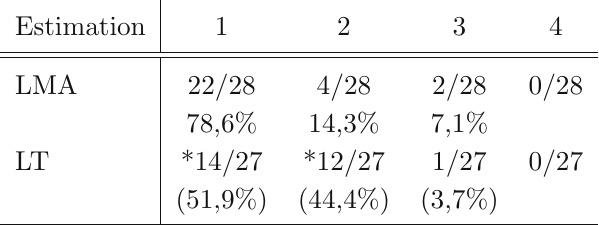
Fig. 1 Intubations attempts with Laryngeal mask Airway (LMA) and Laryngeal Tube (LT), grey = LMA , black =LT. Table 2 Evaluation of the ”positioning” of the two different devices; Laryngeal Mask Airway (LMA) and the Laryngeal Tube (LT).